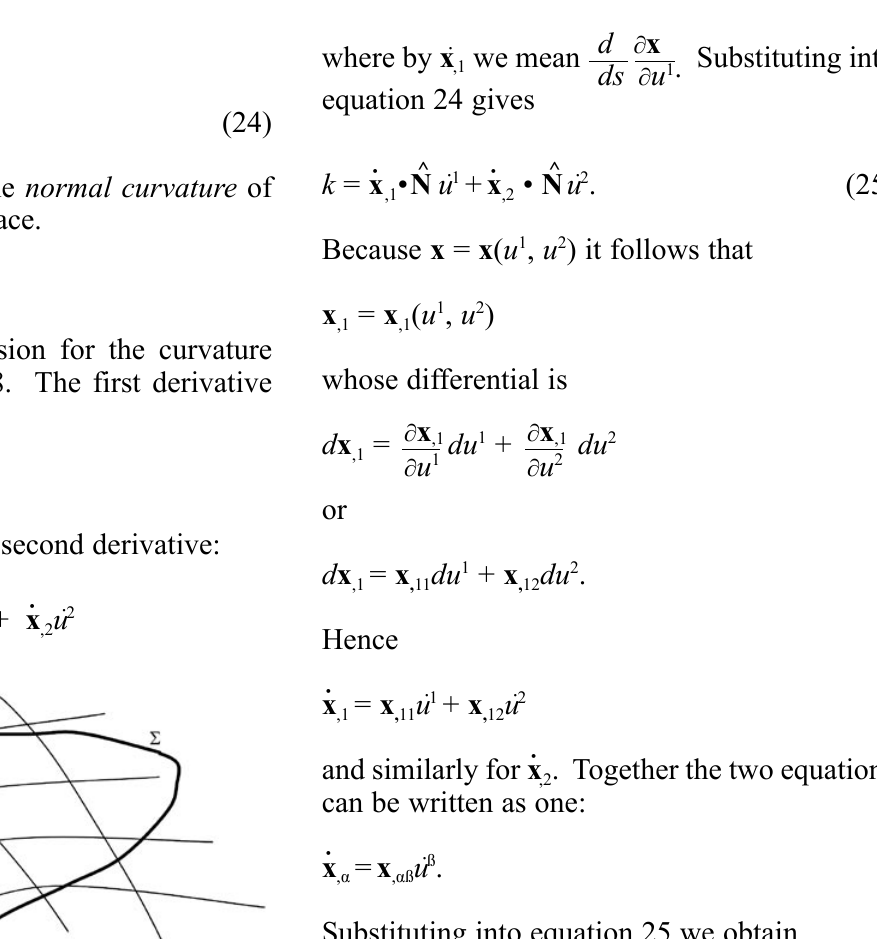
xֵ at the point x of the curve Γ